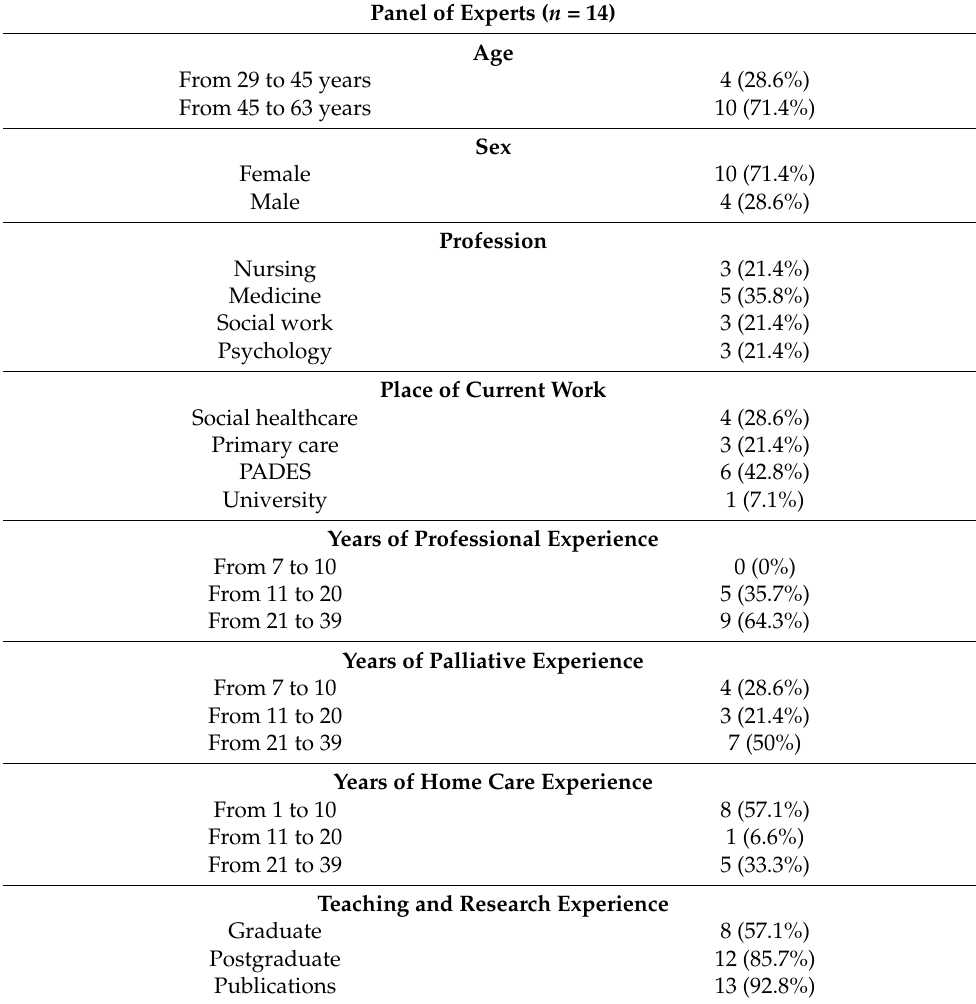
Table 3. Characteristics of the expert